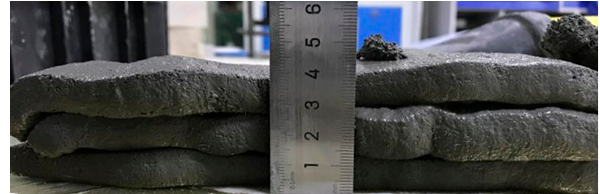
Figure 7. Measure deposit height of printable filament.